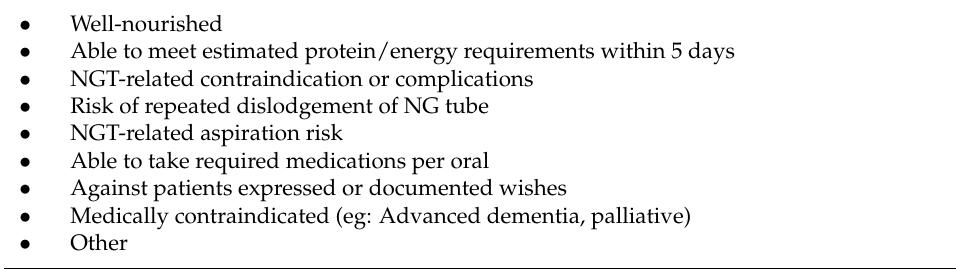
Table 1. Enteral Tube Feeding Decision Support Tool, questions